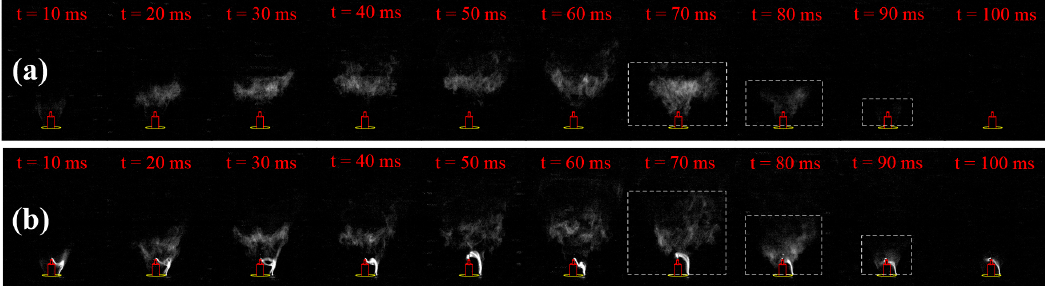
Figure 15. ( a ) The dynamic process of swirl flame in pulsating air flow mode; ( b ) the dynamic process of swirl flame in plasma-pulsating flow mode (sample rate: 30,000 fps, exposure time: 29.23 μ s).